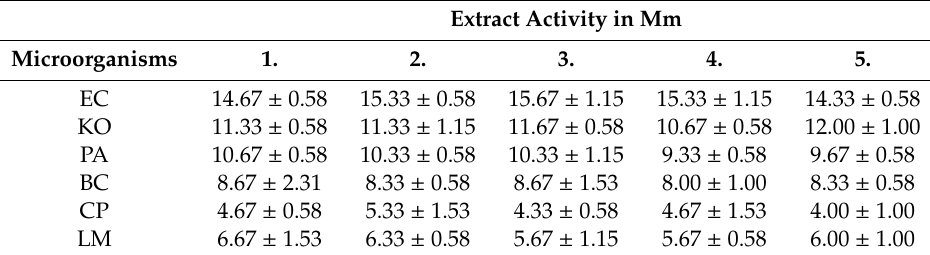
Figure 6. Microscopic fungi in fruits of Rosa canina .